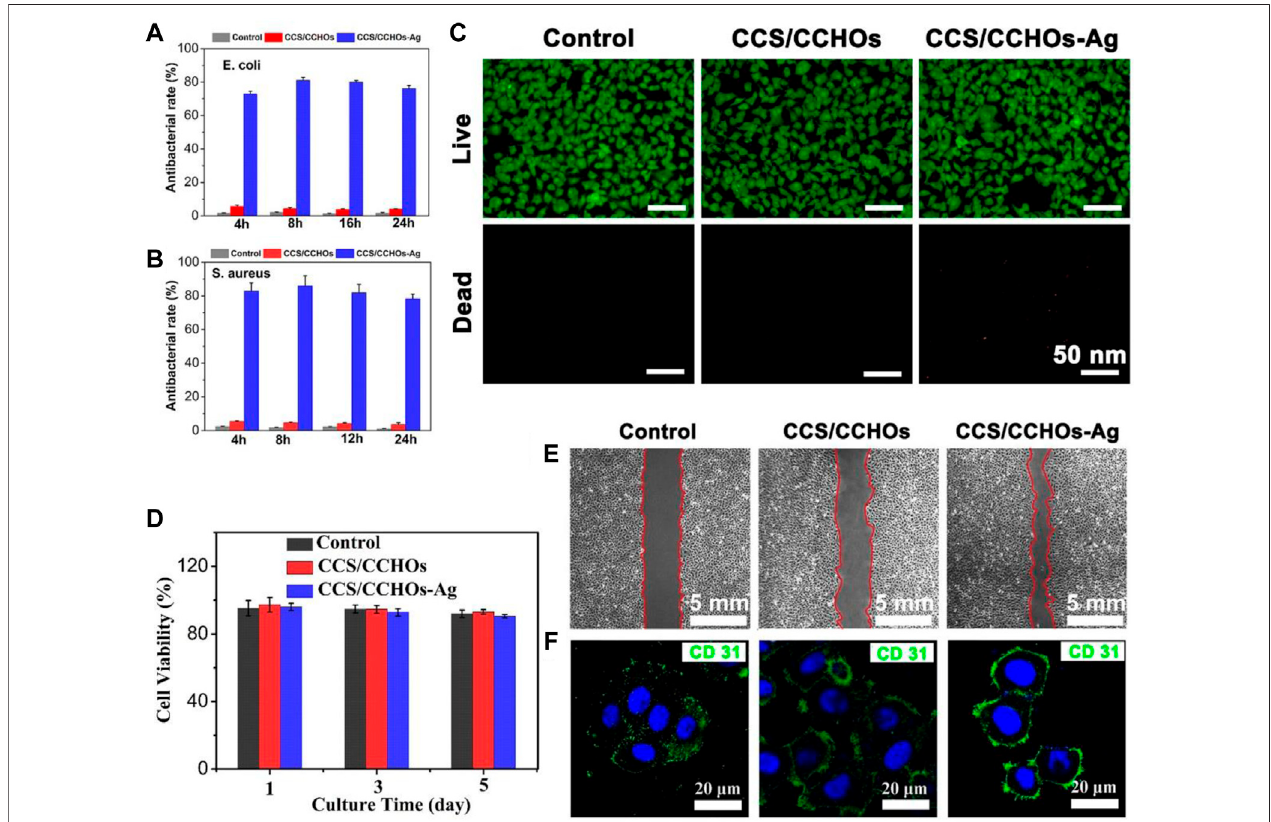
FIGURE 4 | Antibacterial rate of corresponding samples against E. coli (A) and (B) S. aureus after co-culturing for 4, 8, 16, and 24 h. (C) Live/Dead staining of HUVECscultured onhydrogel scaffoldsfor5 days. (D) CCK-8 assayoftheproliferationofcells. (E) TranswellmigrationassaysofHUVECs. (F) Fluorescencestainingfor CD 31 (green) and nucleus (blue) in HUVECs cultured with hydrogel